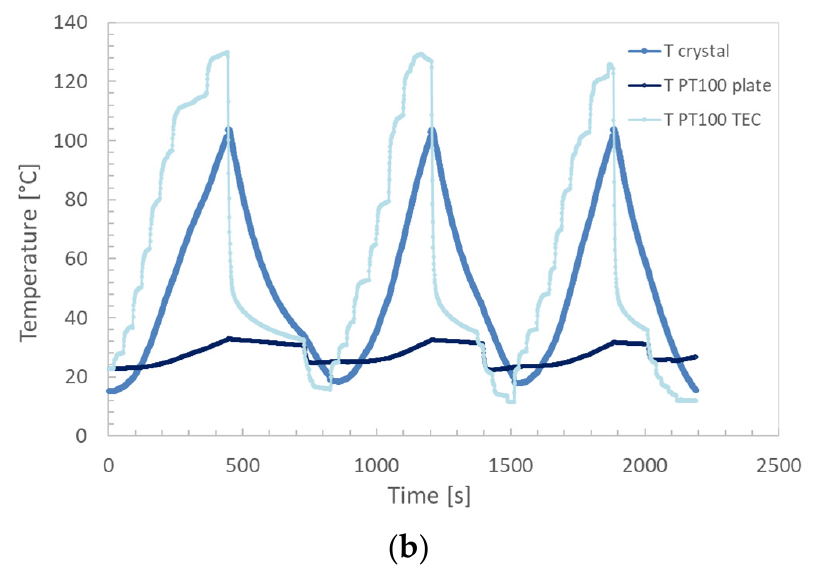
Figure 2. ( a ) Measurement setup for microbalance calibration in vacuum; ( b ) measured temperatures of the crystal, heat sink, and TEC. A flowchart of the crystal calibration procedure is shown in Figure 3.